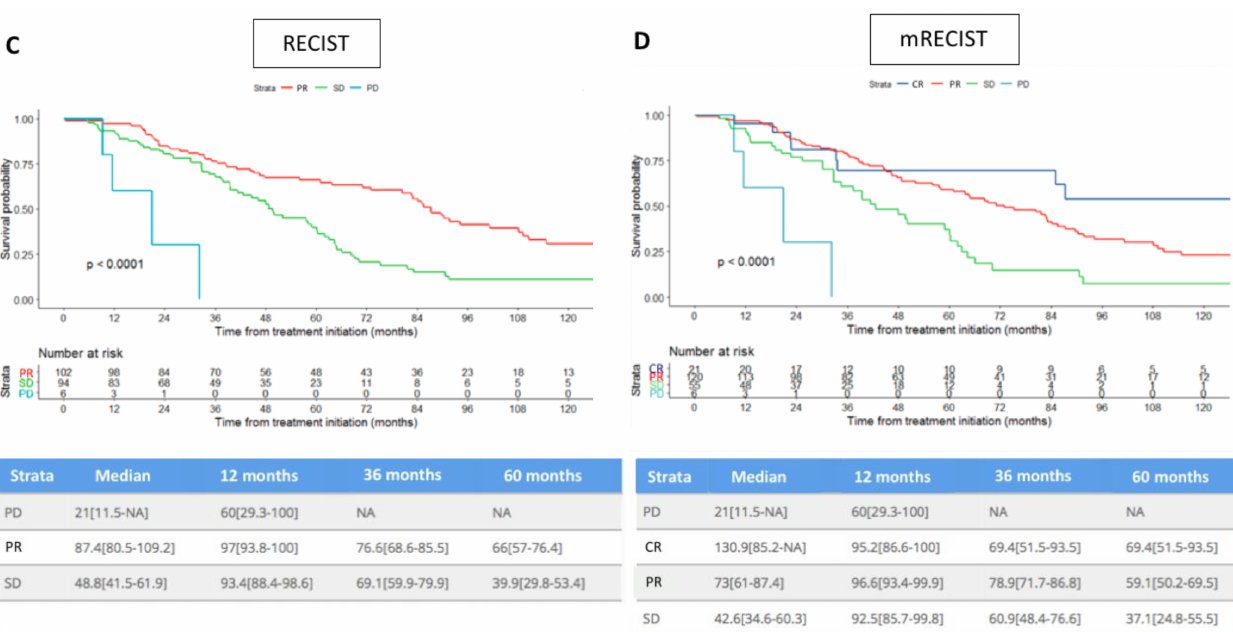
Figure 3. Comparison of estimated overall survival curves (Kaplan–Meier) according to both RECIST and mRECIST, patients being dichotomized as responders or non-responders ( A , B ), or considered according to response categories ( C , D ). PD: progression disease, SD: stable disease, PR: partial response, CR: complete